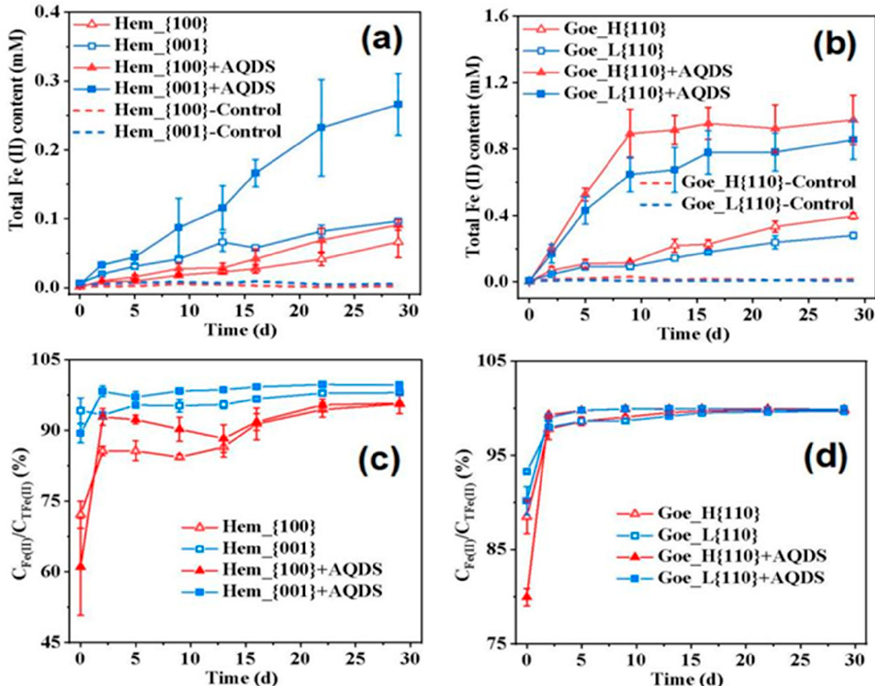
Figure 2. Concentration of the reduced Fe(II) produced from microbial Fe(III) reduction ( a , b ). Per- centage of solid Fe(II) content in the total reduced Fe(II) content ( c , d ). Data correspond to an average of biological triplicates, and the error bars indicate standard deviations. Experimental conditions: bicarbonate − buffered (20 mM); Geobacter sulfurreducens (OD 600 ≈ 0.30); 0 or 50 µ m AQDS; 0.10 g/L iron oxide nanocrystals.